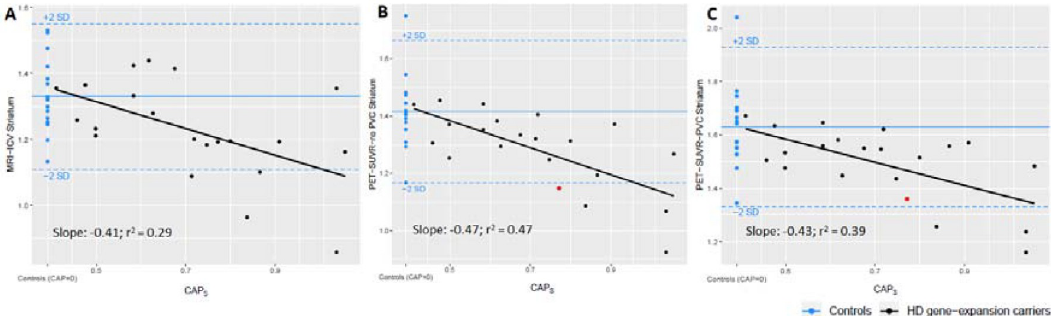
Fig 2. Scatter plots showing the striatal metrics derived as the average of both sides of the MRI volume (%) corrected for intra cranial volume (A), the uncorrected 2-[ 18 F]FDG uptake (SUVR) normalized to cerebellar cortex (B), and the partial volume corrected 2-[ 18 F] FDG uptake (SUVR) normalized to cerebellar cortex (C) vs. the CAP S score. The regression lines were all significant and are shown with slope and r 2 . For comparisons controls are plotted in blue at CAP S score 0 showing mean +/- 2 SD. The measurement, marked in red, represents the participant, who without PVC is under the -2